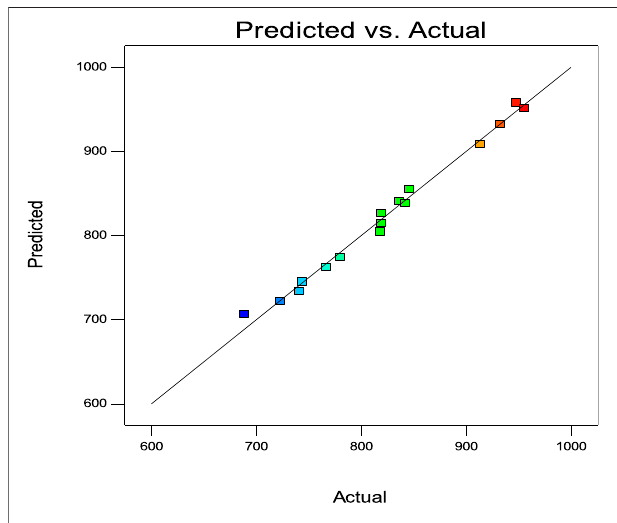
FIGURE3| Wheatandbarleystraw-biocharpelletspredictedandactual responses relationship.